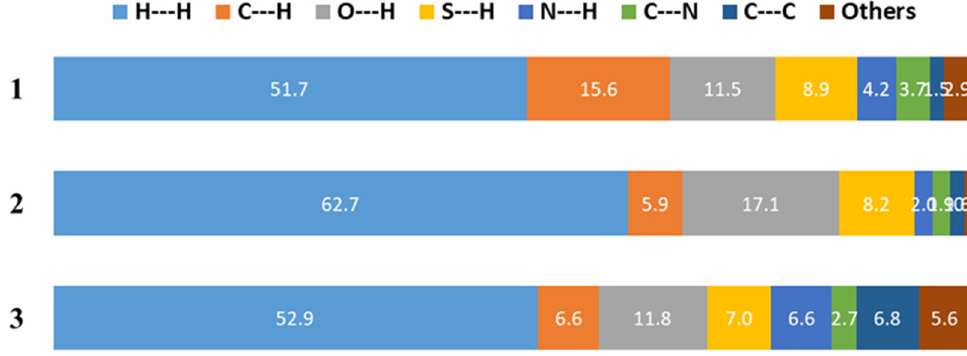
Figure 7. Percentage contribution of each interaction between atoms in 1 − 3.